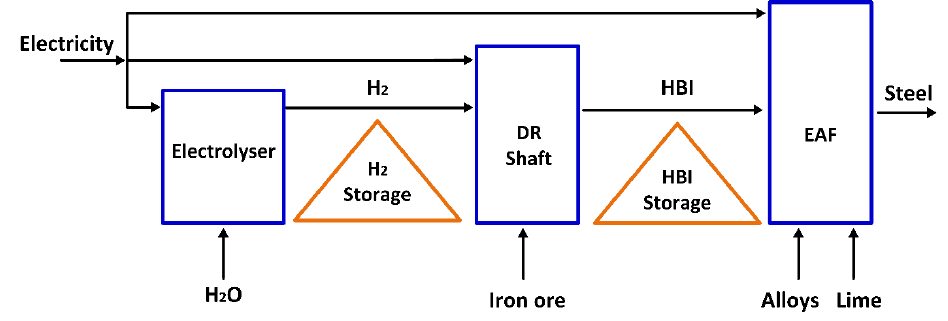
Figure 1. Schematic of the hydrogen-direct reduction (H-DR) process with the three production steps indicated in blue and the two storage options indicated in orange.